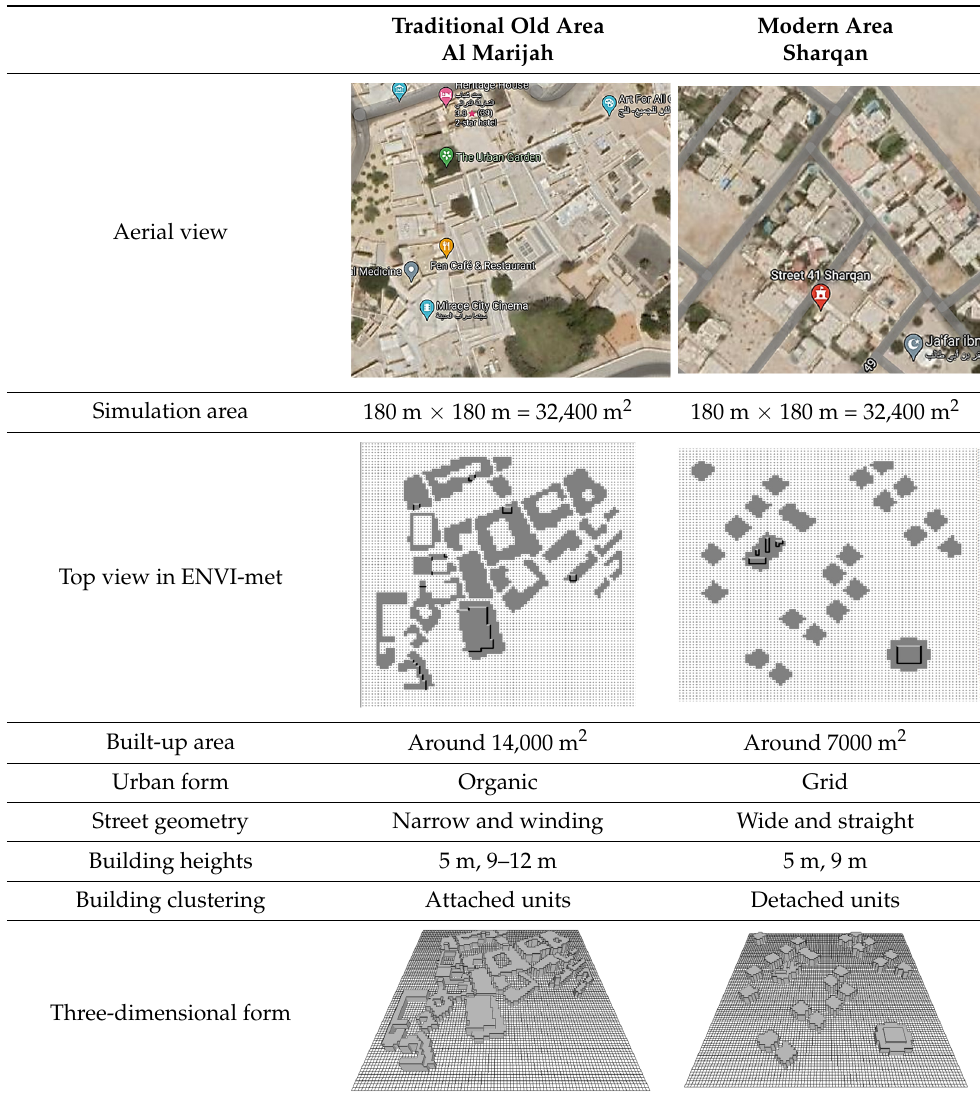
Traditional Old